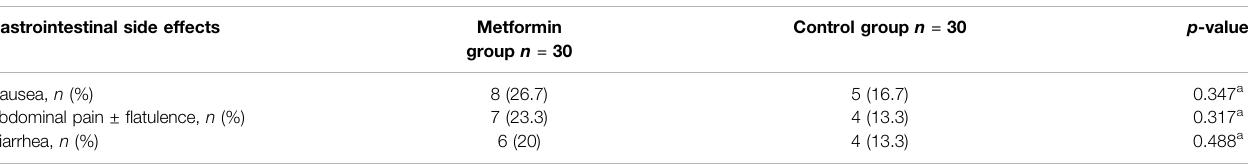
TABLE 4 | Comparison of gastrointestinal side effects between the study groups. Gastrointestinal side